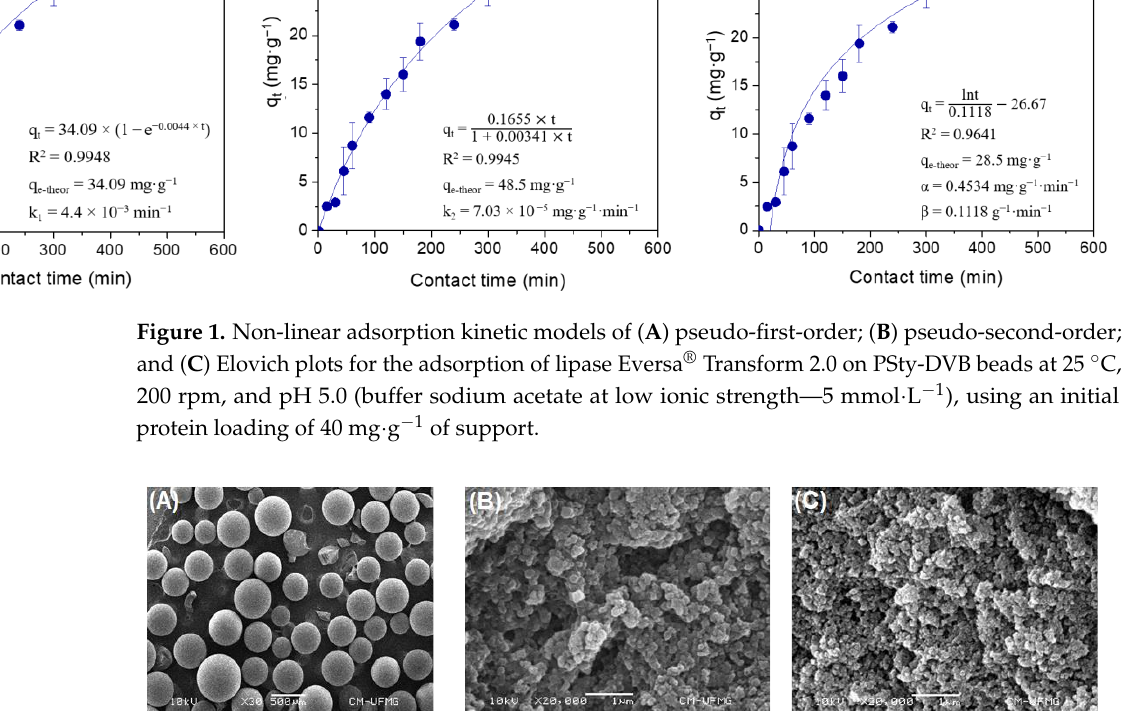
Figure 2. SEM images of PSty-DVB beads at ( A ) 30× and ( B ) 20,000× magnification, and ( C ) immo- bilized lipase at 20,000× magnification.